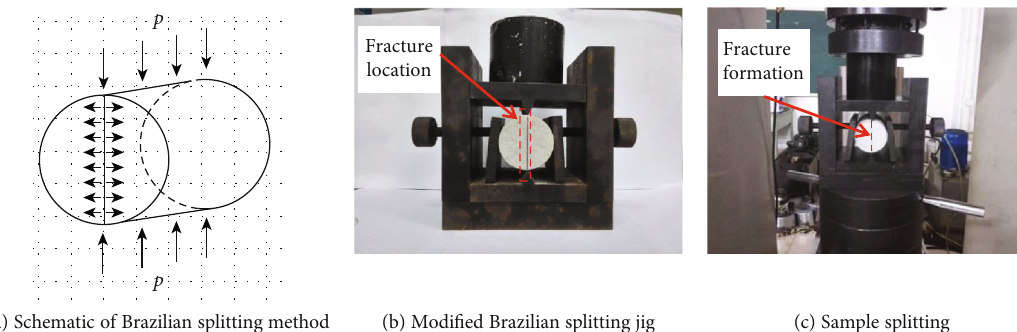
Figure 1: Loading device and loading diagram of modi fi ed Brazil